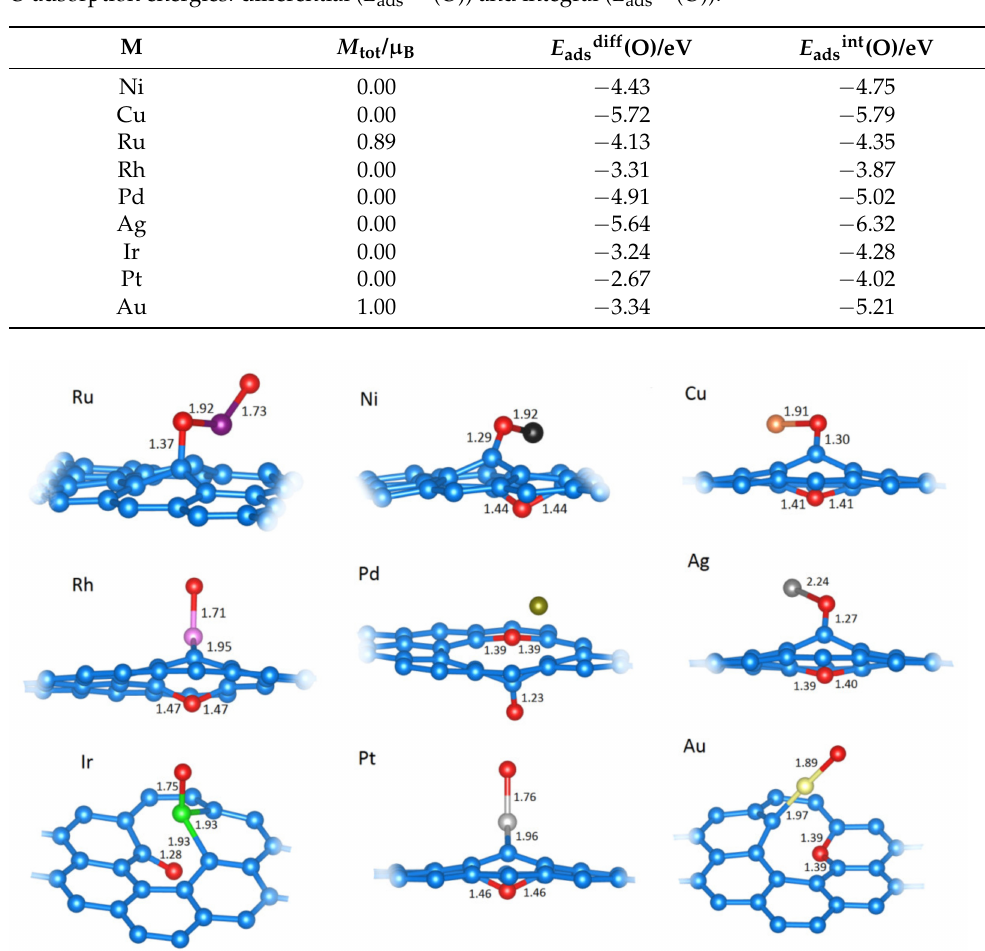
Figure 7. The relaxed structures of the second O at the most favorable positions on C 31 M systems (M is labeled for each structure). M − O, C − O, and C − M bond (depending on O position) lengths are given in Å (if all C − M bonds are of equal length, only one such length is indicated). Structural models were made using VESTA